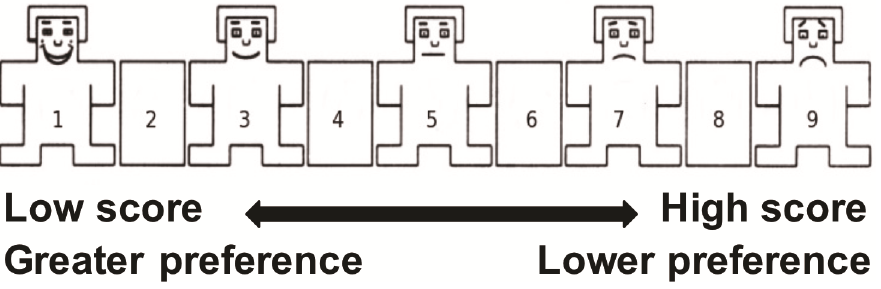
Fig 1. SAM rating